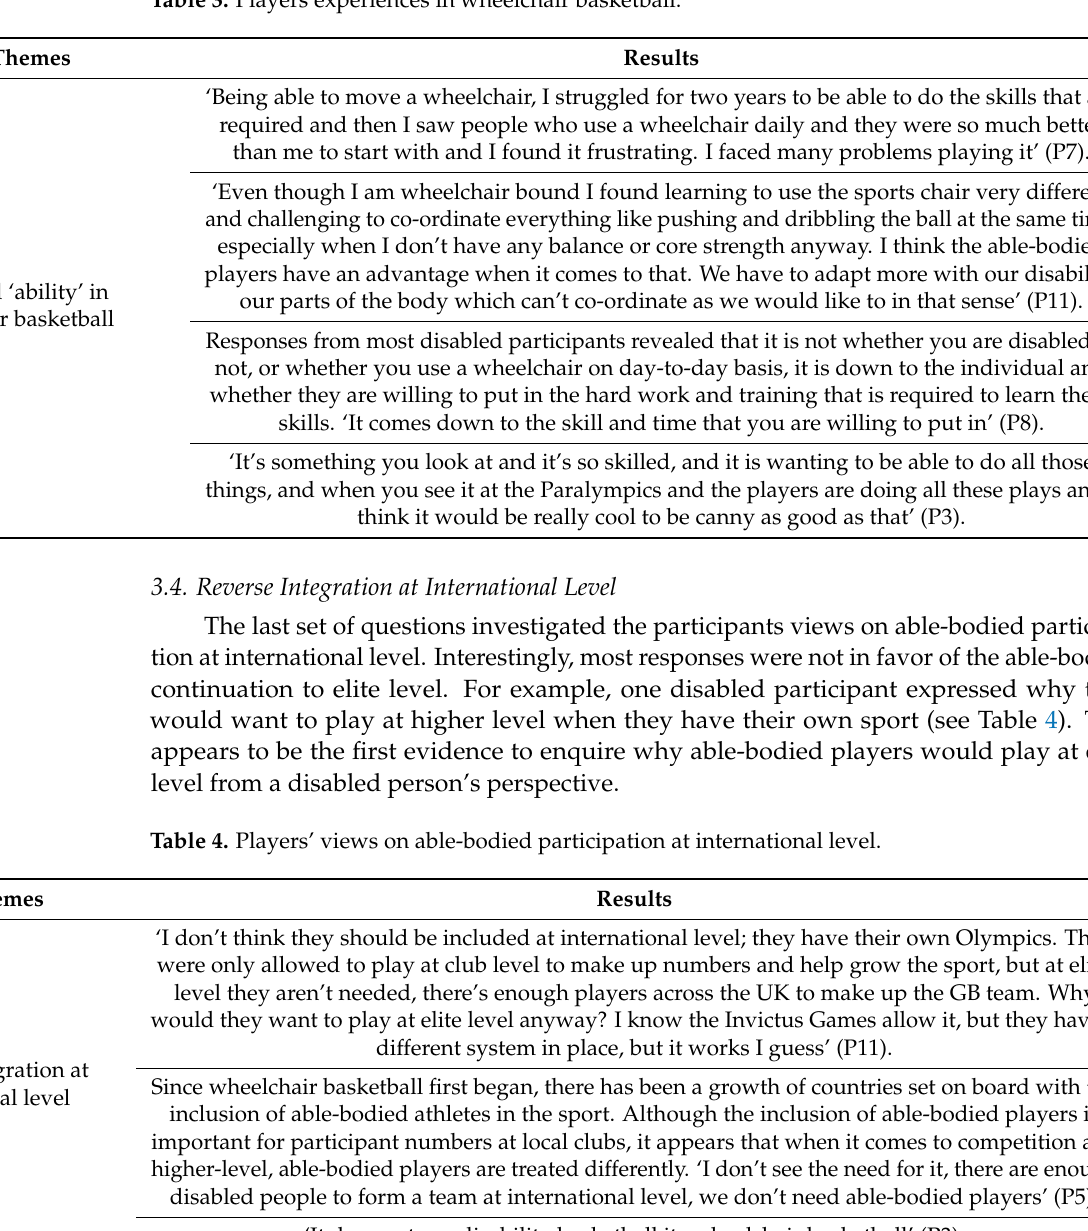
Table 3. Players experiences in wheelchair basketball.